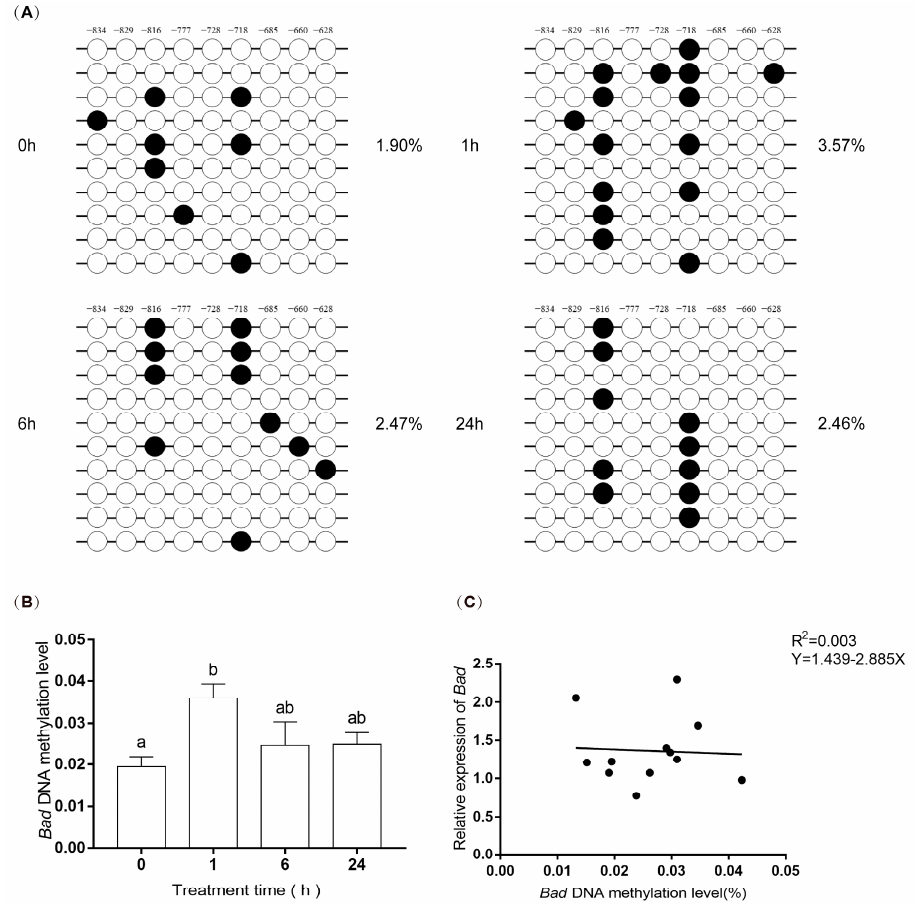
Figure 7. The methylation level of Bad gene promoter at 0 h, 1 h, 6 h, and 24 h after hypoxia. ( A ) The methylation status and levels of Bad gene. The circles show the methylation status. The numbers above the circles represent 9 CpG dinucleotides. The percentage on the right of the circles is the average methylation level of the corresponding group. ( B ) The methylated levels of Bad gene. ( C ) Linear regression analysis of methylation levels and mRNA relative expression levels of Bad .